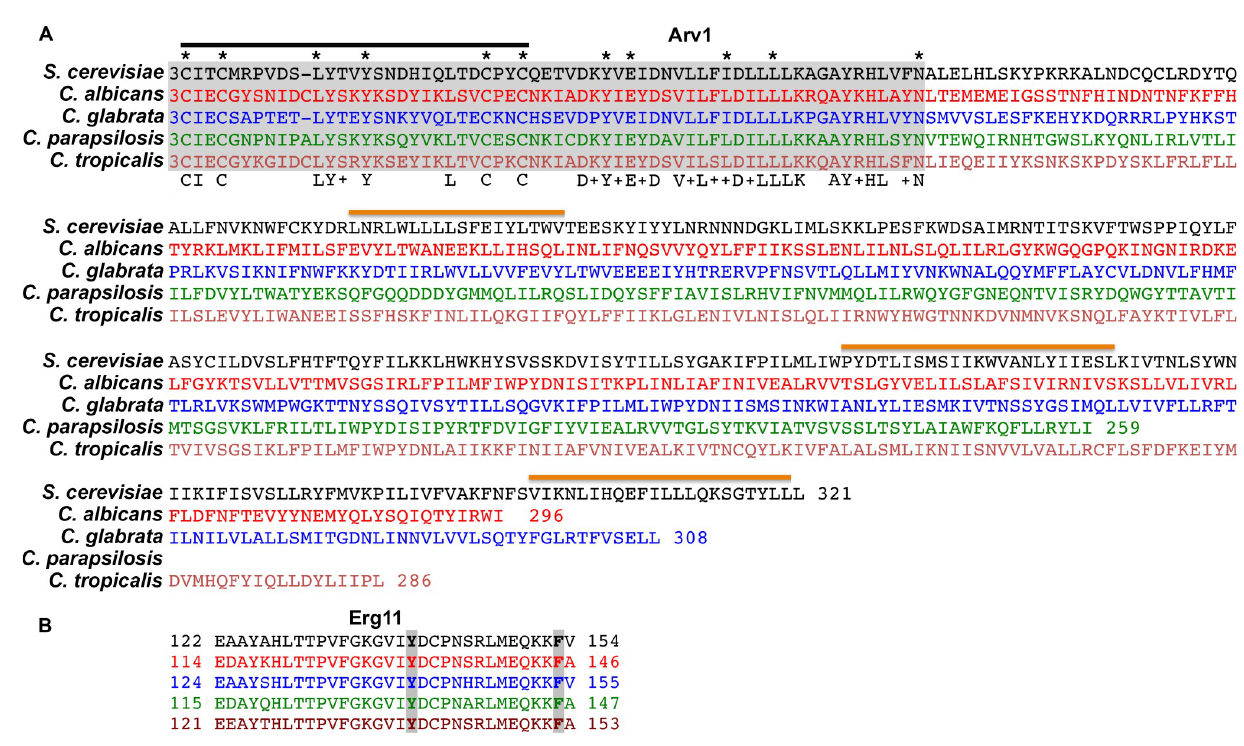
Fig 1. Amino acid sequence alignments of fungal Arv1 and Erg11 proteins. (A) Amino acid sequences of Arv1 proteins from S . cerevisiae , C . albicans , C . glabrata , C . parapsilosis , and C . tropicalis . Ahd (shaded gray); zinc-binding motif (black line); conserved amino acids (lower row); transmembrane domains (orange line); asterisks, (mutated amino acids). All sequences start at amino acid 3. (B) Fungal Erg11 amino acid sequences are shown containing conserved Tyr and Phe residues (shaded